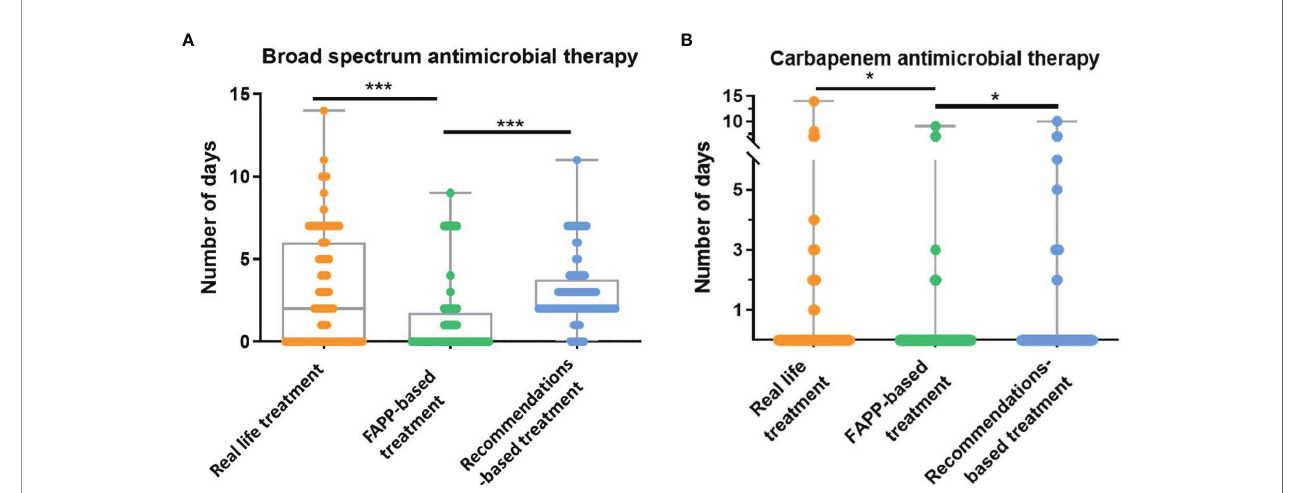
FIGURE 1 | Duration of broad-spectrum antimicrobial therapy. (A, B) . Numbers of days of (A) broad-spectrum antimicrobial therapy (activity against P. aeruginosa), and (B) carbapenems with anti-pseudomonas aeruginosa activity in real-life, in the FAPP-based simulated treatment, and the recommendations-based